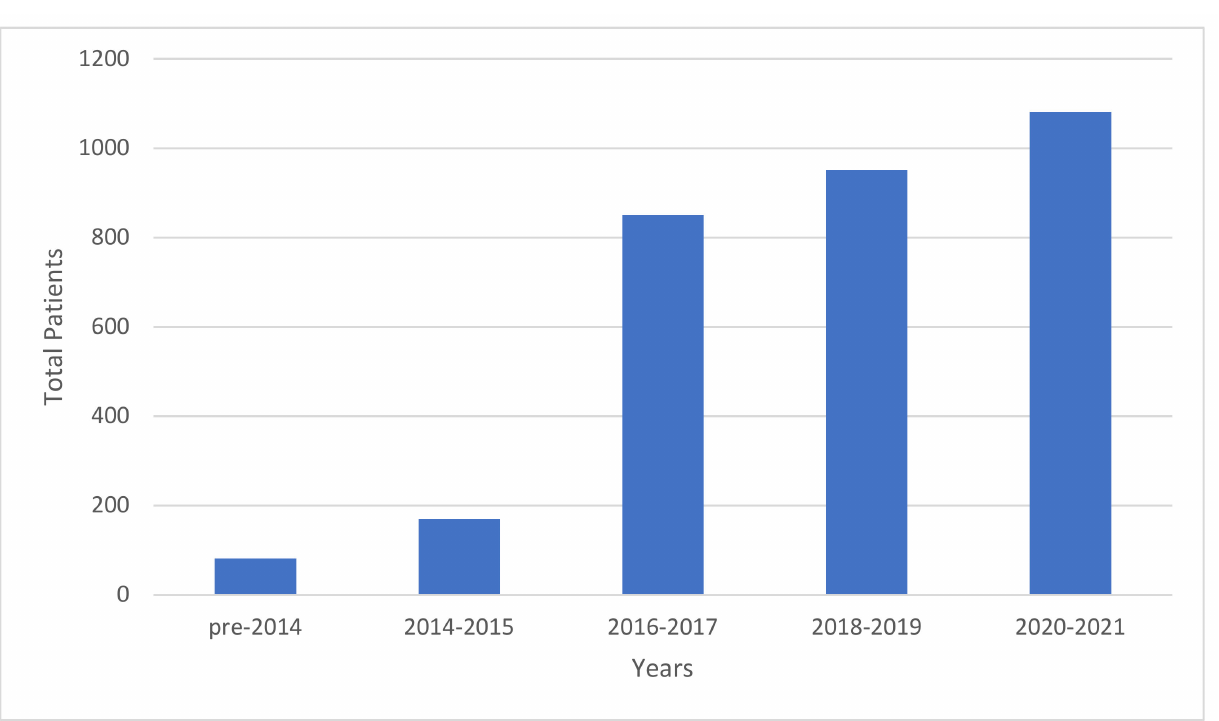
Figure 3. Patients enrolled onto clinical trials assessing the role of liquid biopsy in PDAC. Grouped per 2-year increments